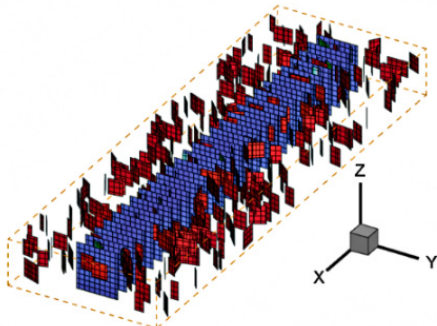
Figure 2. 3D schematic diagram of Barnett gas well model. The pressure, water saturation, and gas saturation distributions of the model in different production periods of 1600 days is shown in Figure 3, and the fitting results of daily gas production are shown in Figure